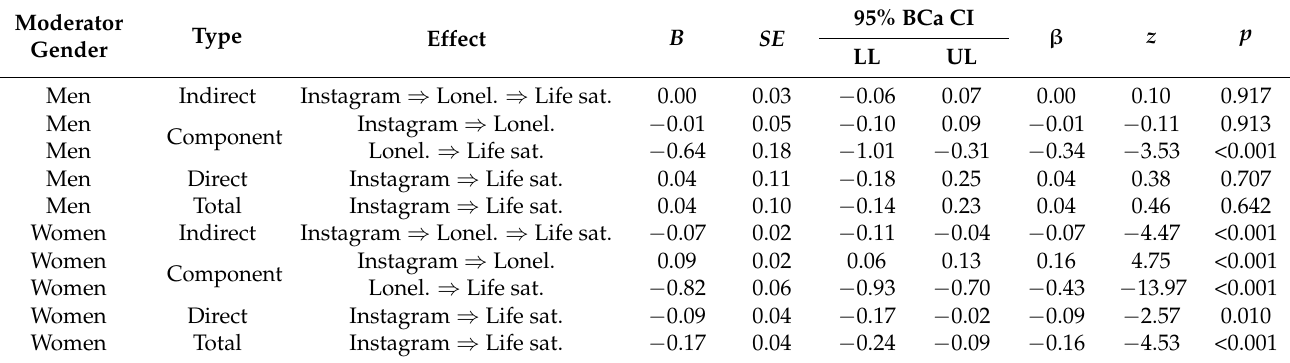
Table 5. The moderating role of gender on the indirect effect of Instagram addiction on life satisfaction via